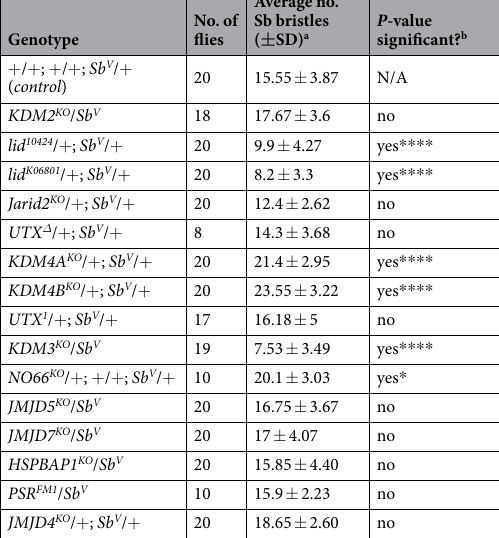
Table 1. JmjC KO modifies Sb V position effect variegation. a 28 bristles were scored per fly. b For each genotype, the mean number of bristles was compared to the control genotype and a statistically significant value was determined using Dunnett’s multiple comparisons test.